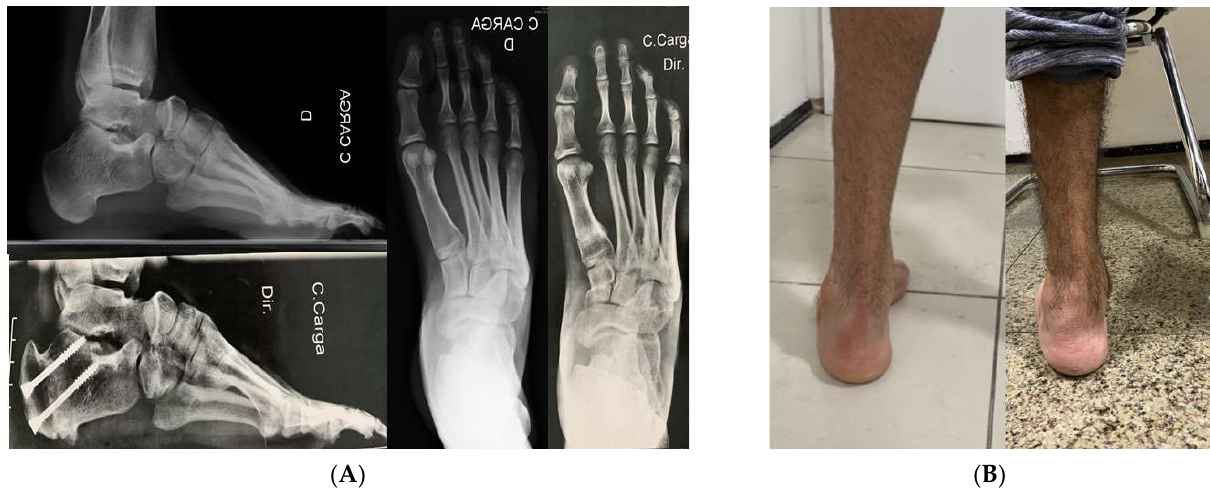
Figure 5. ( A ) We had full consolidation of cuboid and first metatarsal bones without fixation and with immediate weight bearing. ( B ) Clinical improvement of hindfoot alingment.